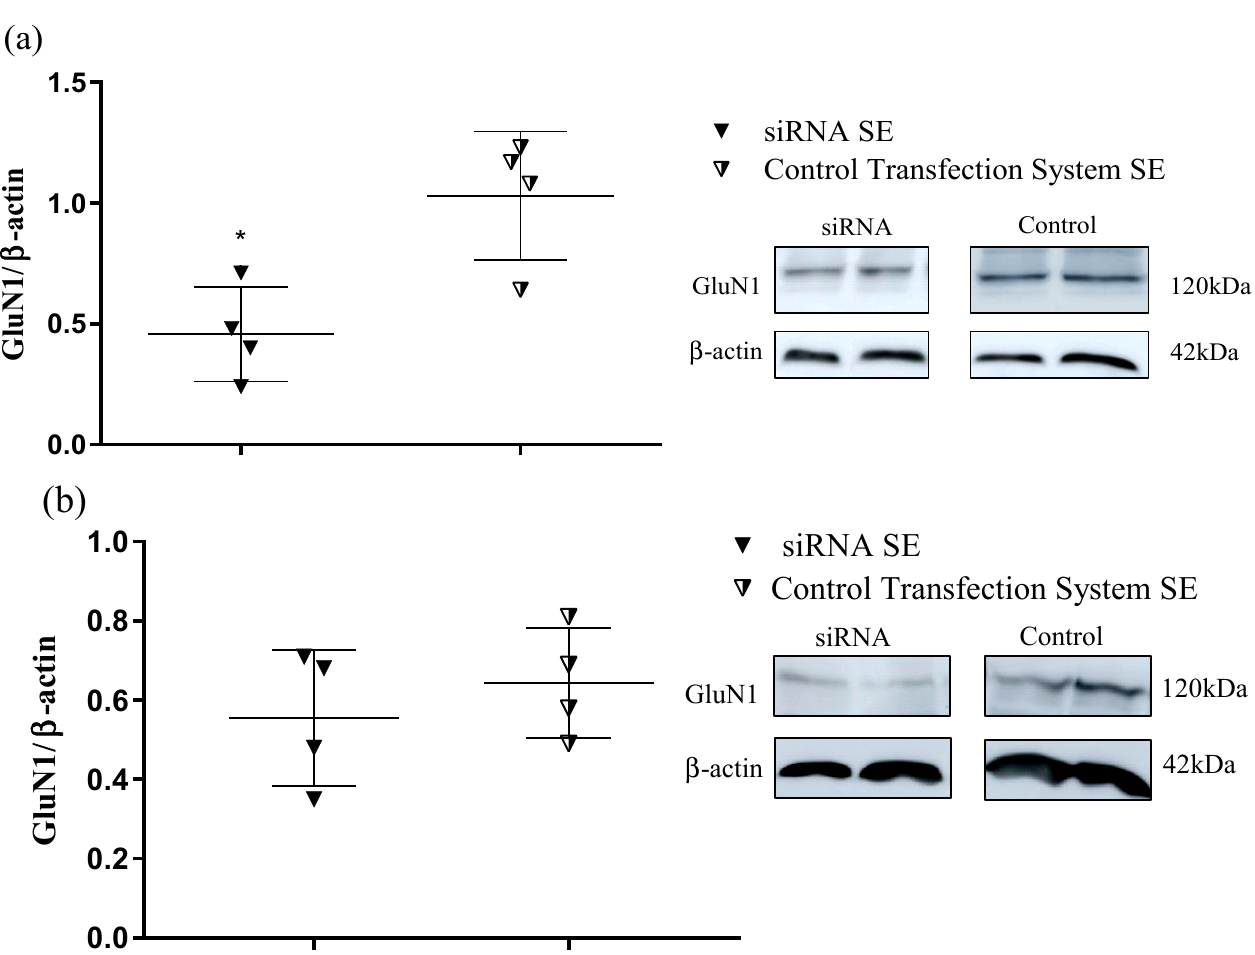
Figure 3. GluN1 protein expression (14 days after intranasal treatment and 24 h later SE) normalized with β -actin, relative to control. Statistical analysis was performed using two-way ANOVA, t -test, and Shapiro–Wilk test * p < 0.05. To optimize the experimental interest, animal groups were divided as follows: CONTROL TRANSFECTION SYSTEM SE (intranasal treatment with transfection system/SE induction after 14 days of intranasal treatment) and siRNA SE: (intranasal treatment with siRNA/SE induction after 14 days of intranasal treatment). ( a ) GluN1—Hippocampus; ( b ) GluN1—Cortex.